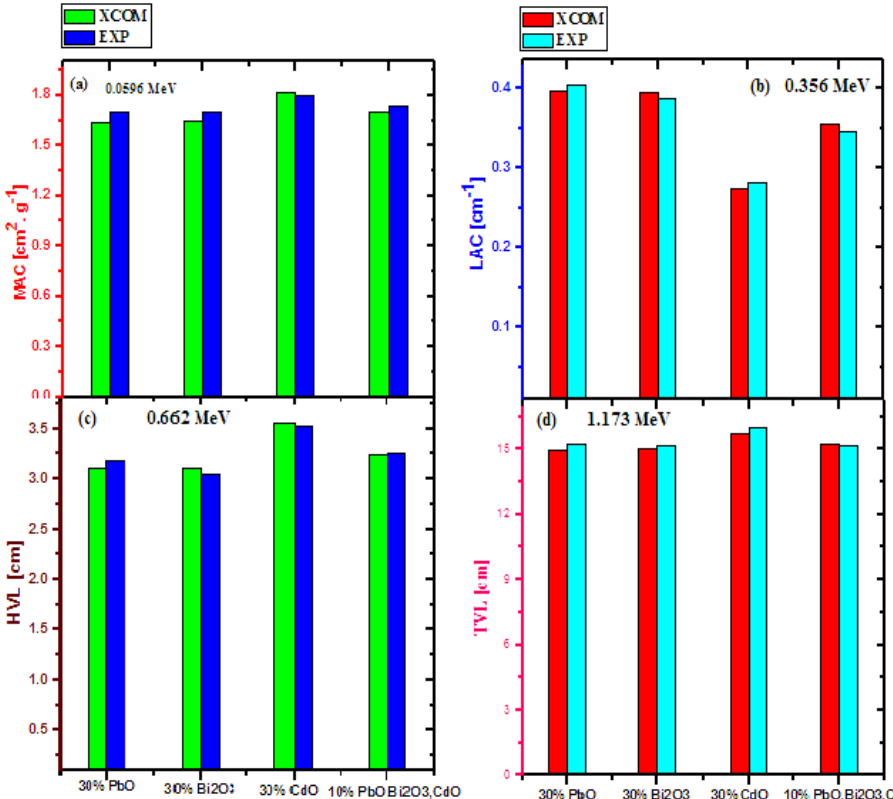
Figure 4. The difference between the experimental and XCOM results of ( a ) MAC at 0.0596 MeV, ( b ) LAC at 0.356 MeV, ( c ) HVL at 0.662 MeV and ( d ) TVL at 1.173 MeV for different 30% wt doped oxide-clays.